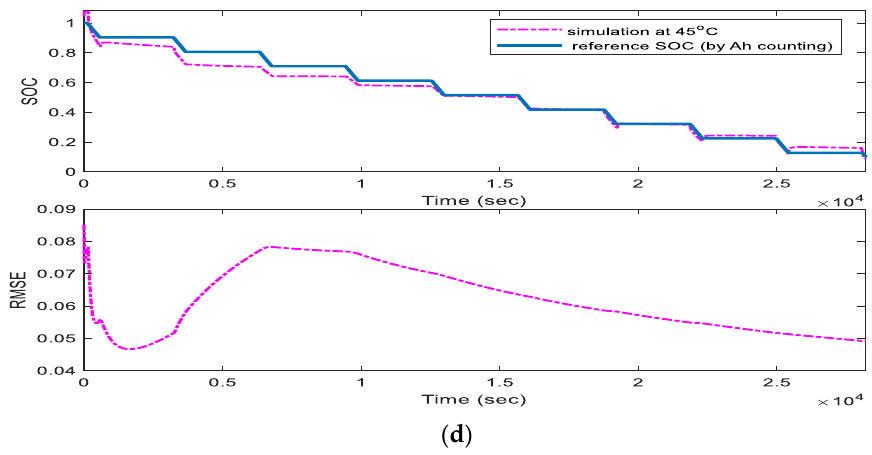
Figure 21. SOC and RMSE of SOC as compared to experimental result at ambient temperature of ( a ) 5 °C; ( b ) 15 °C; ( c ) 35 °C; ( d ) 45 °C.